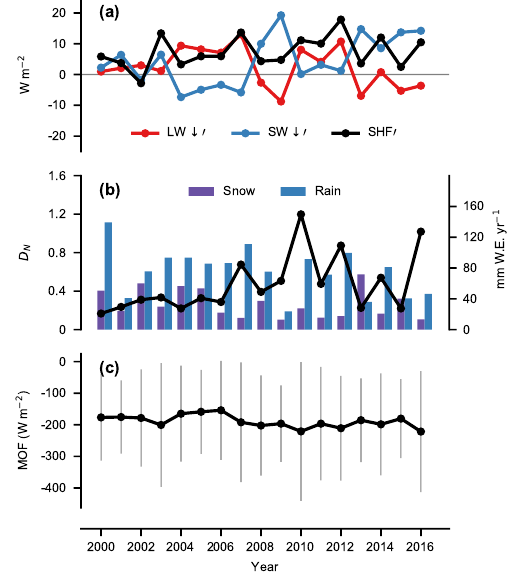
Figure 4. JJA meteorology and D N from 2000 to 2016. (a) SW ↓ (cid:48) , LW ↓ (cid:48) and SHF (cid:48) (see Sect. 2.5). (b) Normalised darkness ( D N ), total snow inputs from e t B until 31 August and rain inputs during